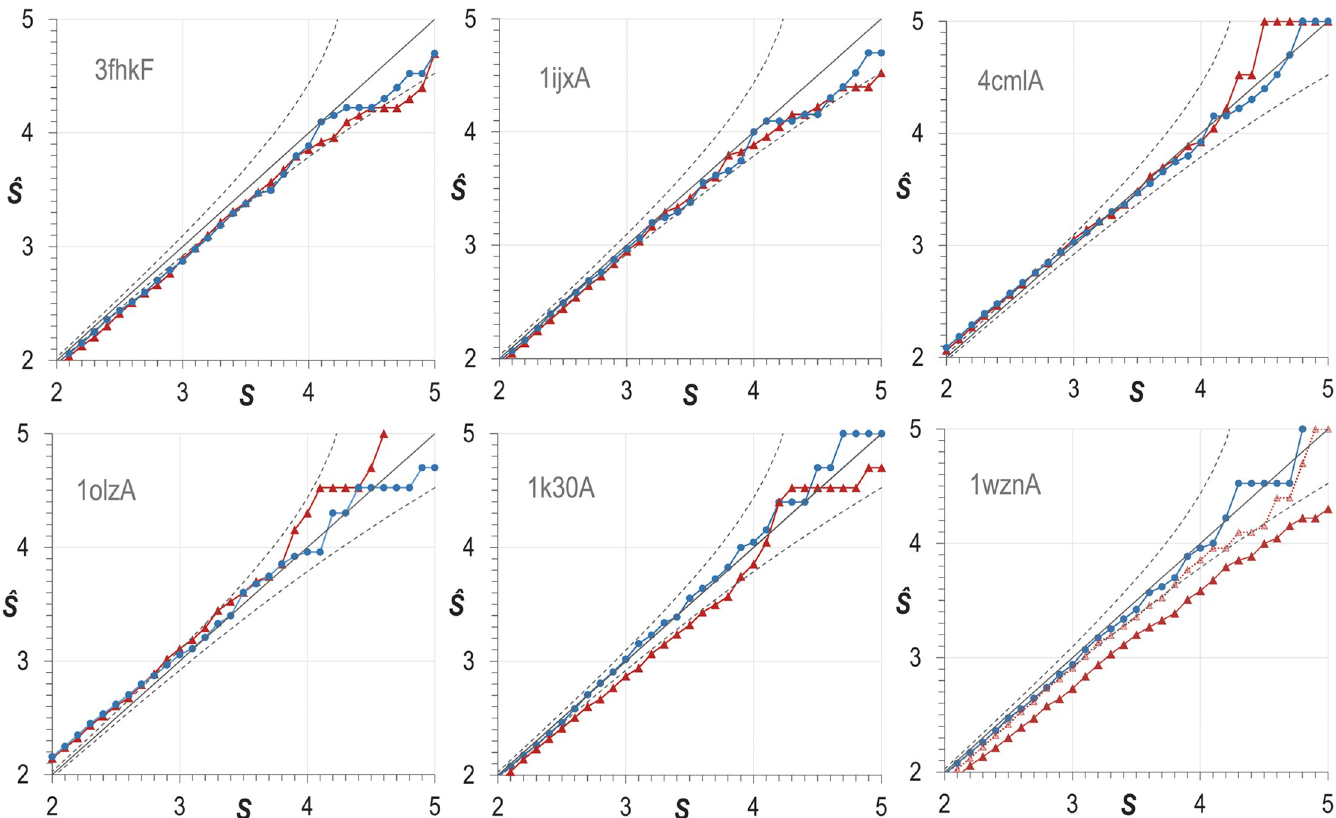
Fig 1. Empirical values of Ŝ as a function of S yielded by randomly shuffled 100,000 DCA arrays (blue dots connected by lines), and by 100,000 DCA arrays derived from column-permuted MSAs, where the order of the columns and of the residues within each column were randomly permuted (red triangles connected by lines). Solid straight lines represents agreement of Ŝ with S , and the dashed curves represent an error range of two standard deviations. Results are shown for six of the domains listed in Table 2, designated by their corresponding pdb identifiers 3fhkF, 1ijxA, 4cmlA, 1olzA, 1k30A, 1wznA, ordered by increasing numbers of sequences in their corresponding MSAs. For 1wxnA, the additional data points (faint red triangles connected by a dashed line) corresponds to an MSA of 5,117 sequences randomly drawn from the original